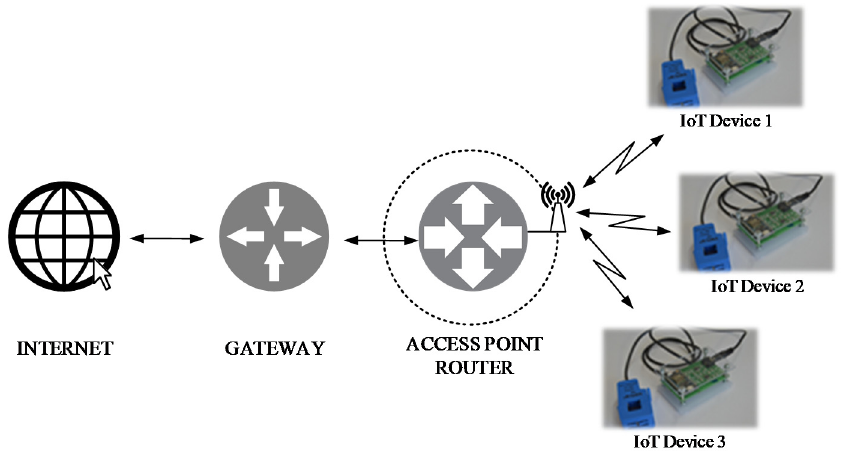
Figure 7. The network topology of the proposed IoT system.